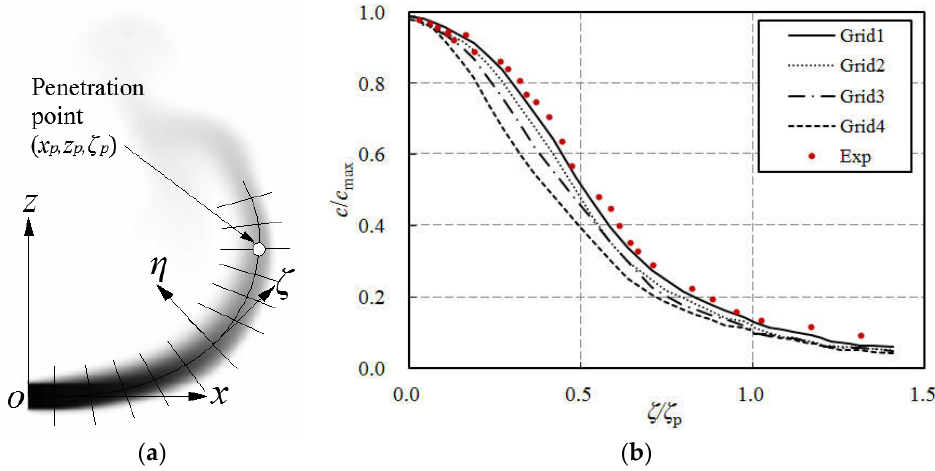
Figure 9. ( a ) Longitudinal setting of the axial coordinate system of from the mean concentration contour with F = 5 and R = 7.5. ( b ) The normalized centerline concentration along the jet trajectory. On the basis of the uncertainty analyses, concentration contours, coherent structures, and centerline concentration, as well as the relationship between the numerical accuracy and computational resources, the buoyant jet in counterflow was appropriate on grid 1 for F = 5 and R =